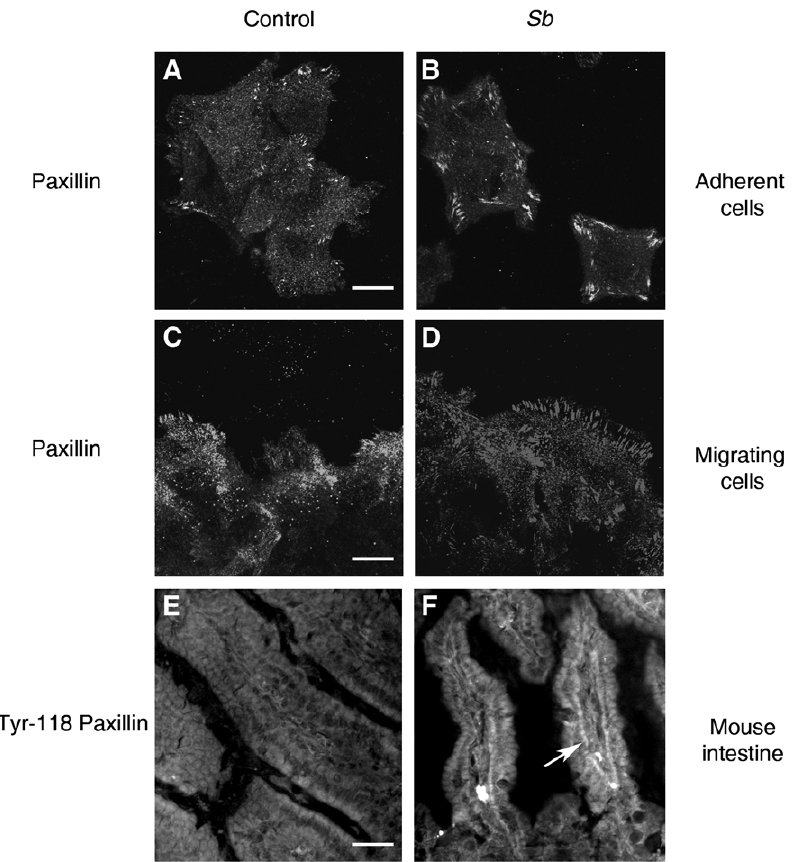
Figure 10. Sb modulates integrin signaling pathway both invitro and invivo . HCT-8/E11 cells were pretreated ( B ) or not ( A ) for 2 hours with Sb supernatant, and then allowed to adhere to type I collagen-coated surfaces (3 m g/ml) for 30 minutes. After fixation and permeabilization, cells were stained with an anti-paxillin Ab, the binding of which was revealed with an AlexaFluor 488-conjugated anti-mouse secondary Ab. Scale bar: 20 m m. HCT-8/E11 cell monolayers were wounded and incubated without ( C ) or with ( D ) Sb supernatant for 5 hours. Paxilin was revealed using a specific anti-paxillin Ab. Scale bar: 20 m m. Intestinal tissues from control ( E ) or Sb force-fed mice ( F ) were immunostained with an Ab against Tyr-118 paxillin. Stainings were analyzed using a Leica confocal microscope. Scale bar: 100 m m.